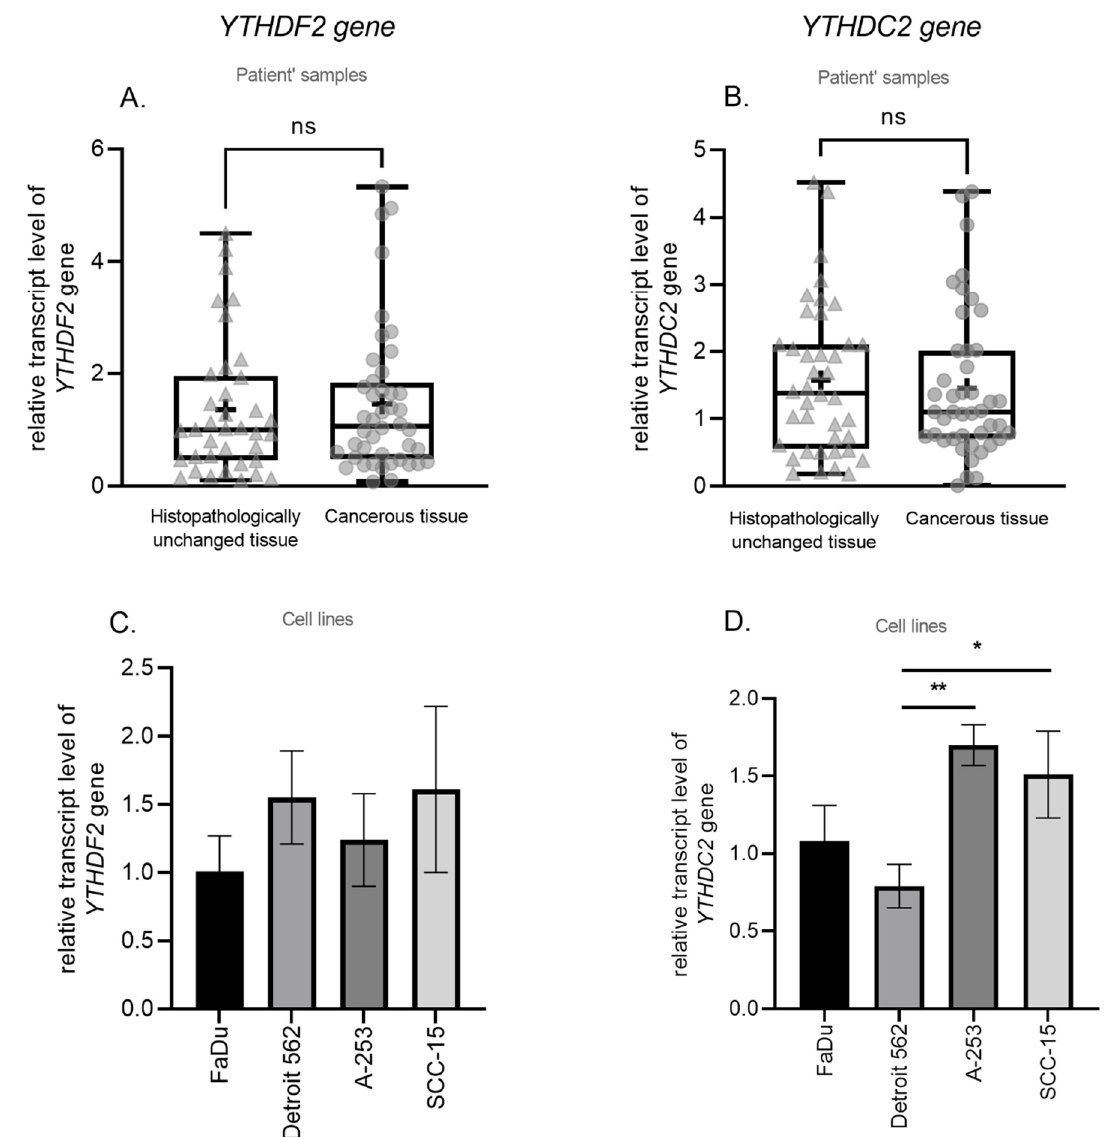
Figure 4. The transcript level of ( A ) YTHDF2 and ( B ) YTHDC2 genes in cancerous and histopathologically unchanged tissues from patients with HNSCC and cell lines ( C , D ). ns (non-significant), + (mean value), * ( p ≤ 0.05), ** ( p < 0.01).